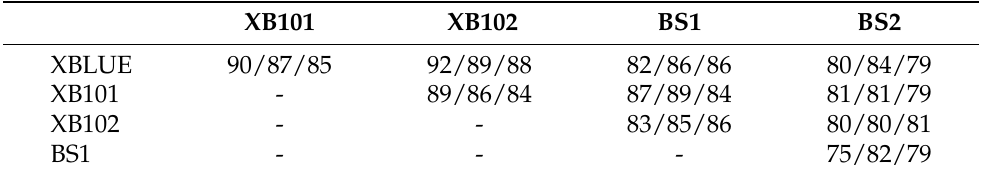
Table 3. Maximum CC coefficients for each component (HJ3/HJ2/HJ1) and each sensor in % in a example for the comparison of the sensors XBLUE and XB101 is shown in Figure